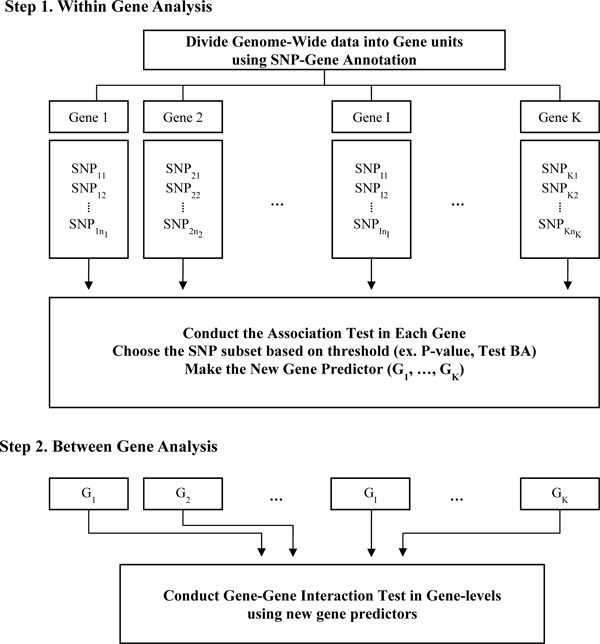
Flow chart of Gene-MDR analysis.